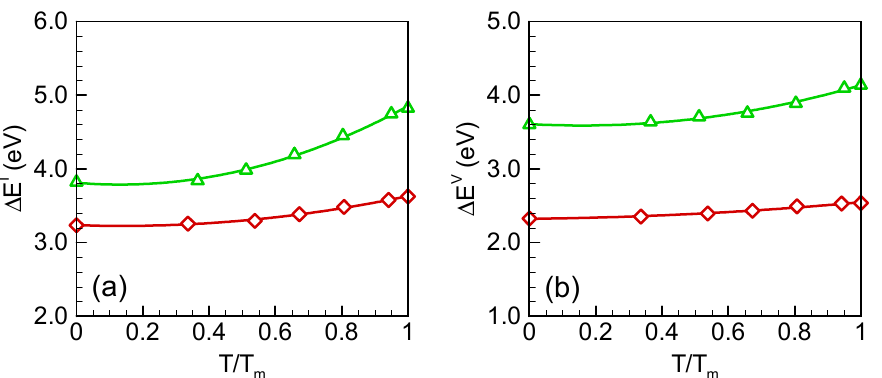
Figure 1. Formation energies of ( a ) self-interstitial ( b ) vacancy in germanium crystal. Red diamond and green delta symbols represent SW and Tersoff potential results, respectively. The lines are quad- ratic-fitted.